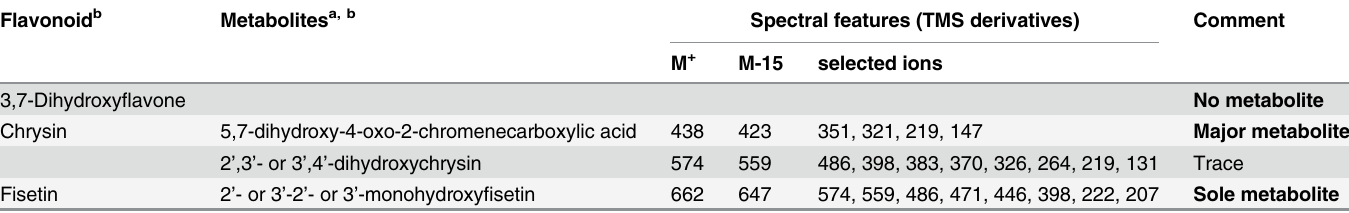
Table 6. Metabolites produced by strain U23A during co-metabolic growth on di- or tri-hydroxyflavones. Flavonoid